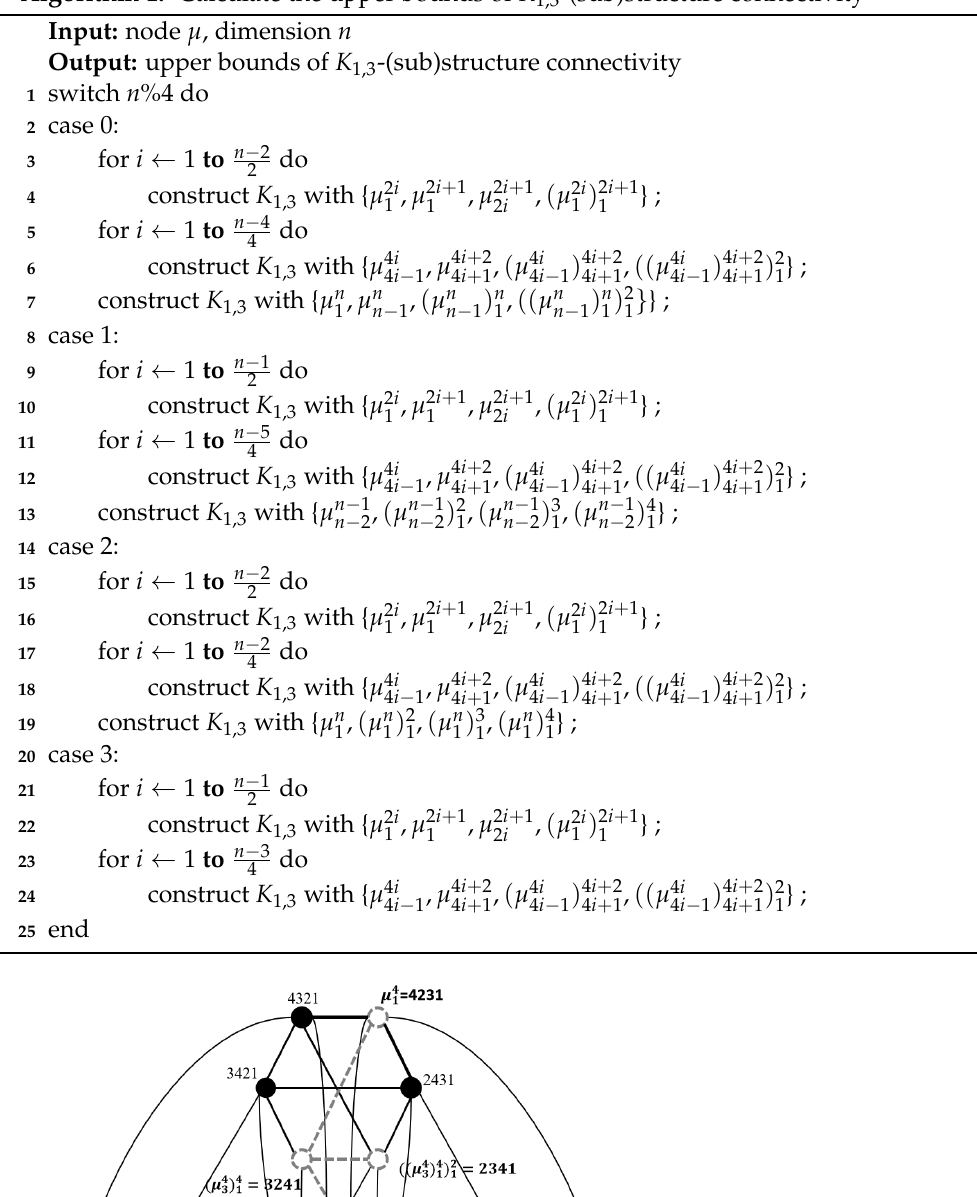
Algorithm 1: Calculate the upper bounds of K 1,3 -(sub)structure connectivity